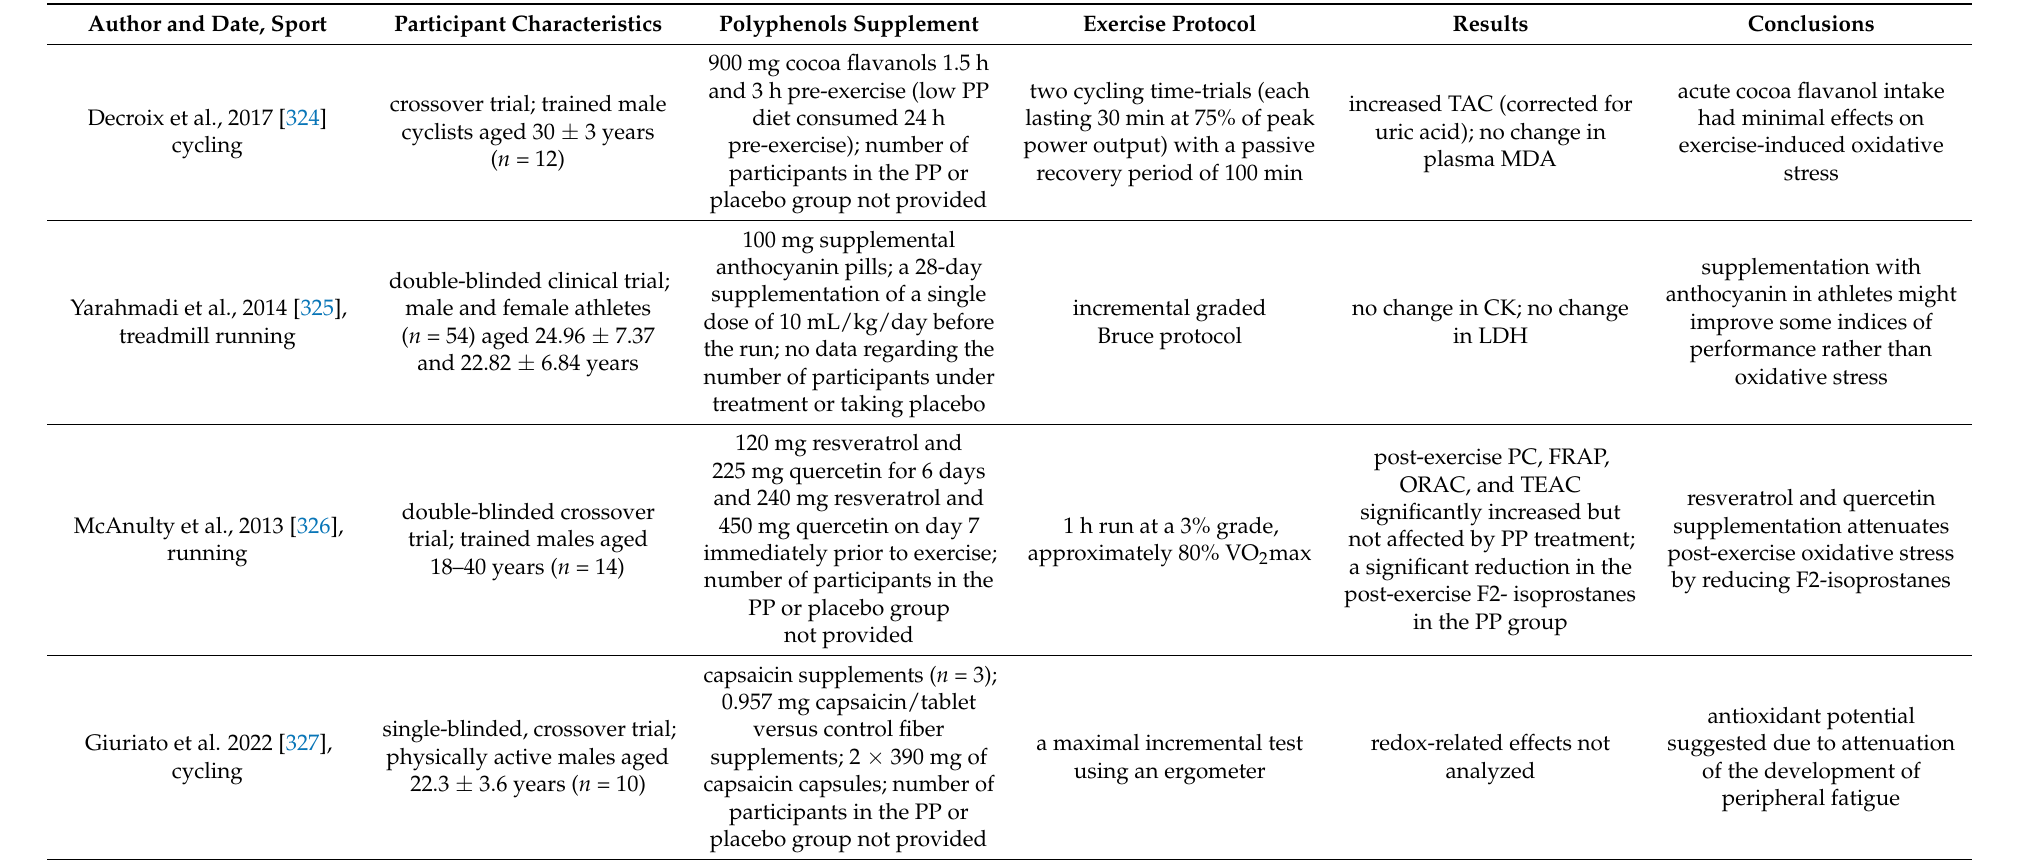
Table 2. Effect of dietary polyphenol supplementation on oxidative stress induced by heavy exercise training in